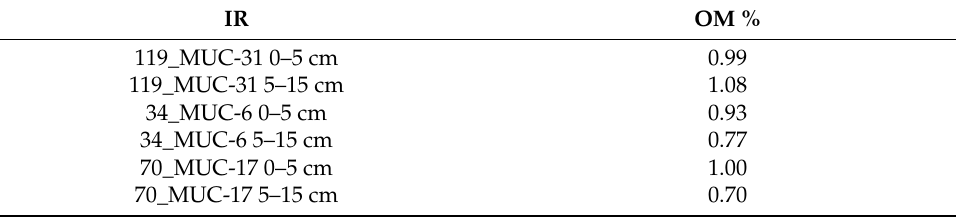
Table A4. Quantitative determination of organic carbon after combustion of the